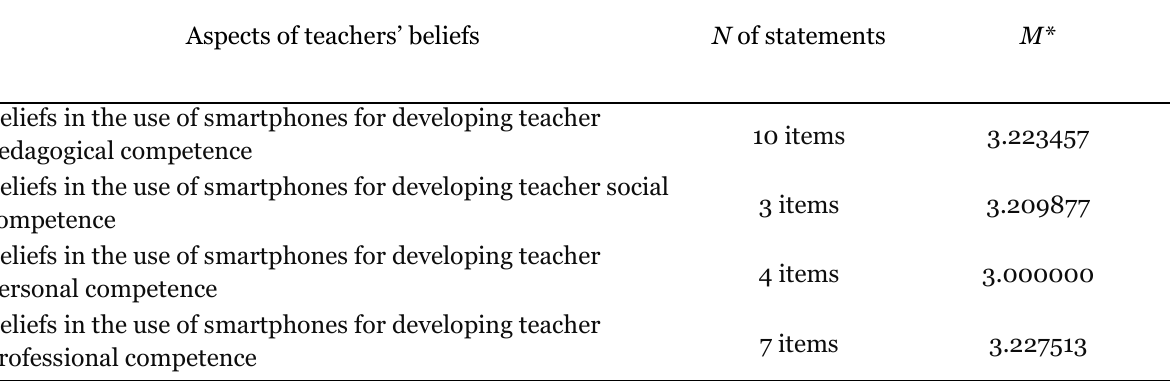
English Teachers’ Beliefs in the Use of Smartphones for Developing Various Competences